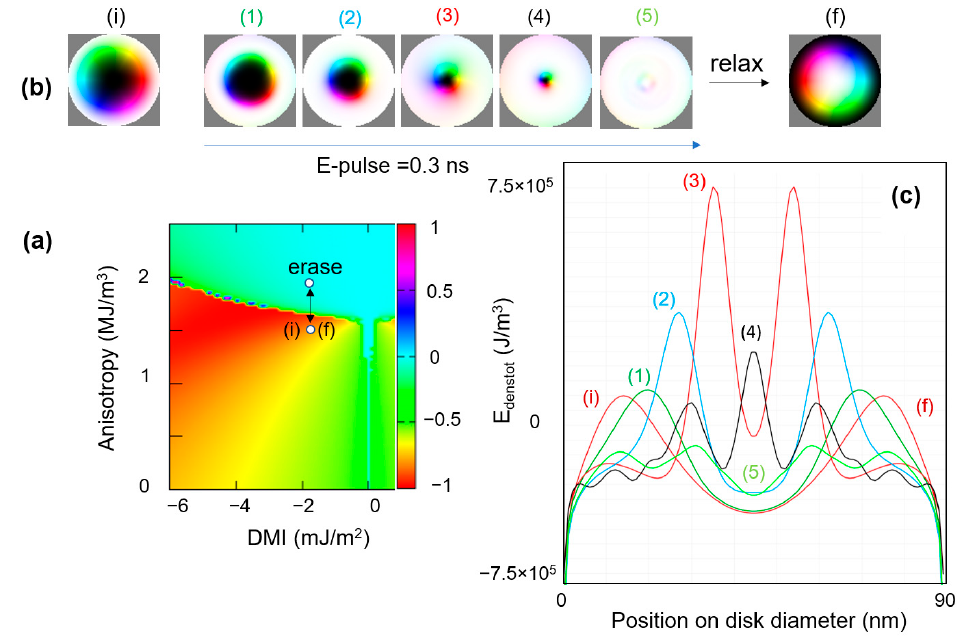
Figure 25. ( a ) Zoom on the DMI-PMA-Q phase diagram. ( b ) Micromagnetic states of skyrmion: (i) = initial state, (1)–(5) intermediate states during the E-field pulse, (f) final state, after cutting the pulse. ( c ) Line profiles of the total magnetic energy density in the disk.